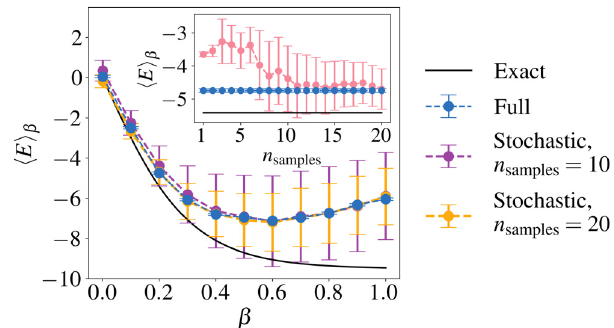
FIG. 9. Finite-temperature energy (cid:9) E (cid:7) β of the four-site TFIM with J = 3, h = 1 versus inverse temperature β using full- and stochastic trace evaluation. QITE is performed with recom- piled D = 2 unitaries with a time step of (cid:3)τ = 0.05. Results of stochastic trace evaluation are shown with the number of sam- ples n samples set to 10 and 20. Inset shows the running average of β = 0.2 (cid:9) E (cid:7) β versus n samples using stochastic trace evaluation at (red symbols), with full trace evaluation (blue symbols) and exact results (black solid line) plotted as constant values. Stochastic trace evaluation with ten samples is already sufficient to repro- duce the results from full trace evaluation across a wide range of β